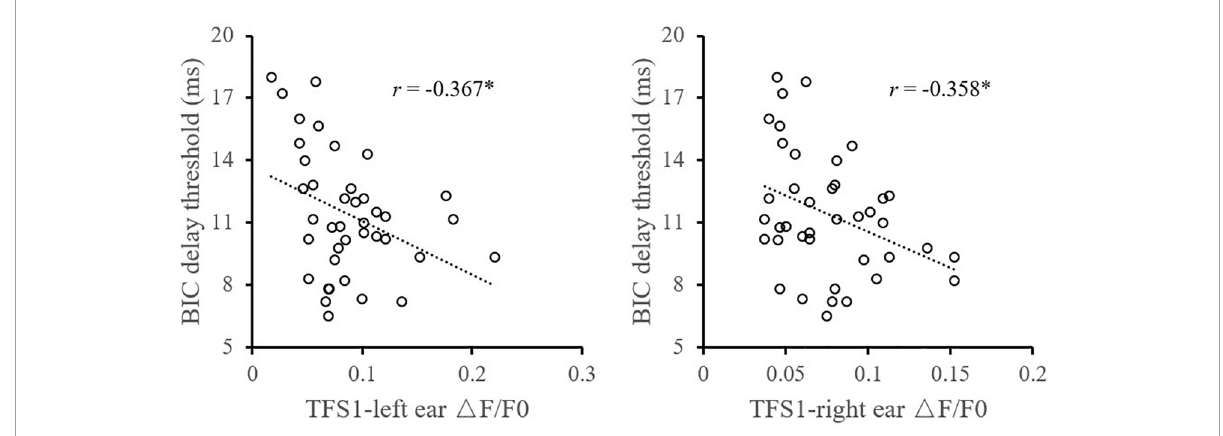
FIGURE4 Illustration of the correlation analysis of the BIC delay threshold and the TFS1 and TFS-AF test. ∗ Significant effect after Bonferroni’s correction, p <